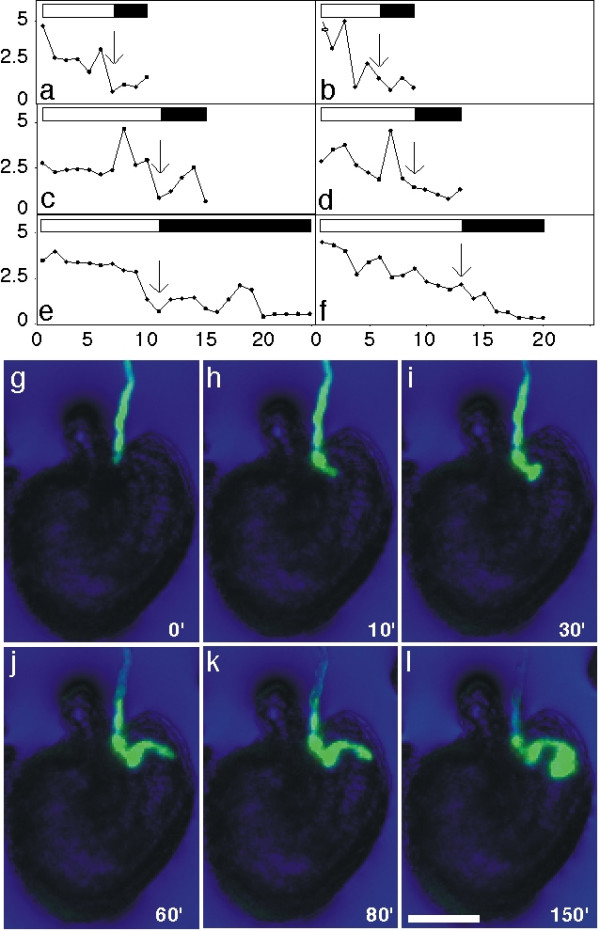
Pollen tube navigation time course. (a–f) Graphs of position (μm; X axis) versus growth rate (μm/min; Y axis) for six pollen tubes, from the moment they exit the style (white bar), enter the micropyle (arrow) and navigate within the ovule (black bar). (g–l) Merged fluorescent and bright field images of a GFP-tagged pollen tube entering a micropyle (g), navigating past diploid ovule cells (h–j), and pausing upon reaching a synergid (k), and completing lysis (l). Characterstics of pollen tube growth within the ovule shown in G-L were graphed and shown in (e). Time is min ('); scale bar, 50 μm.